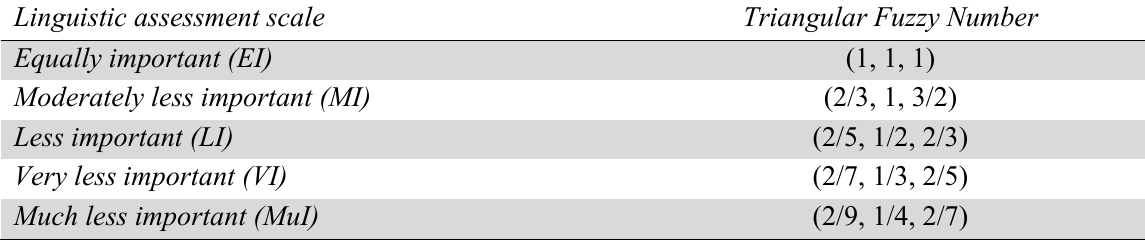
The fuzzy scale for the relative weight of criteria (Chang, 1996)